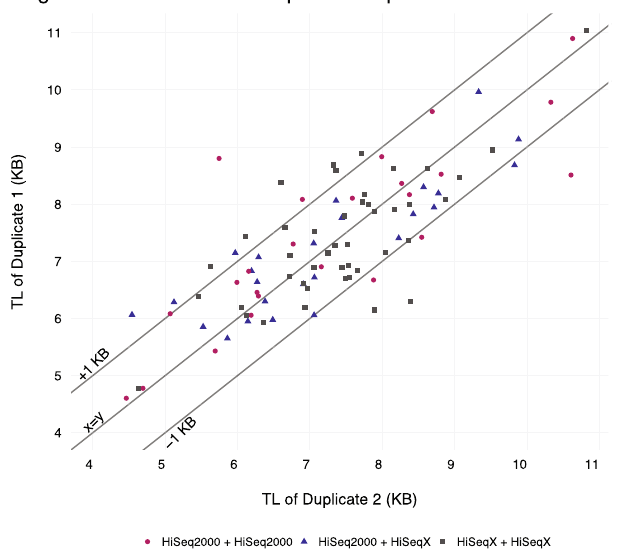
Figure 4. A plot of telomere length (TL) estimates for repeated measurement pairs. Colours correspond to the sequencing platform of each sample in the